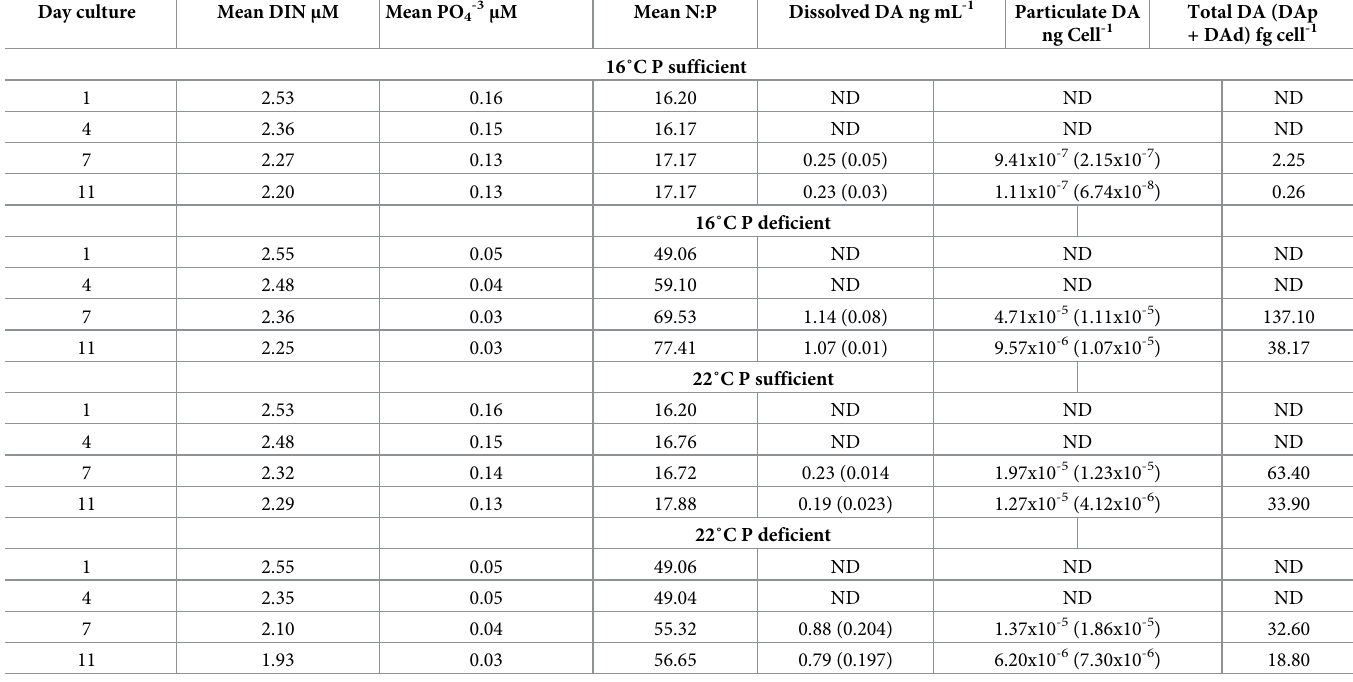
Table 2. Concentration of particulate (DAp) and dissolved domoic acid (DAd) in Pseudo-nitzschia subpacifica in triplicate cultures grown at two temperatures in P-sufficient and P-deficient medium of strain Ps 291. The mean value and the standard deviation (SD) are shown. Day